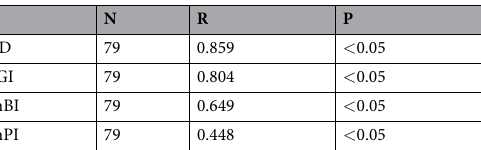
Table 4. Correlation between the concentration of HMGB1 and the clinical parameters of peri-implant disease. Spearman rank correlation coefficients were used to assess the correlation between the HMGB1 concentration and the clinical parameters of peri-implant disease.